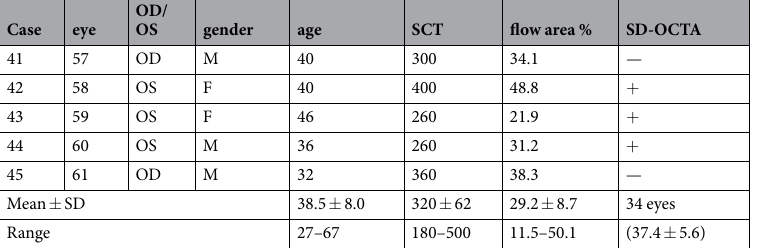
Table 1. The characteristics of all cases. SCT ( µ m) = subfoveal choroidal thickness. flow area (%) = ratio of choroidal blood flow area by SS-OCTA. SD-OCTA = spectral domain optical coherence tomography angiography.